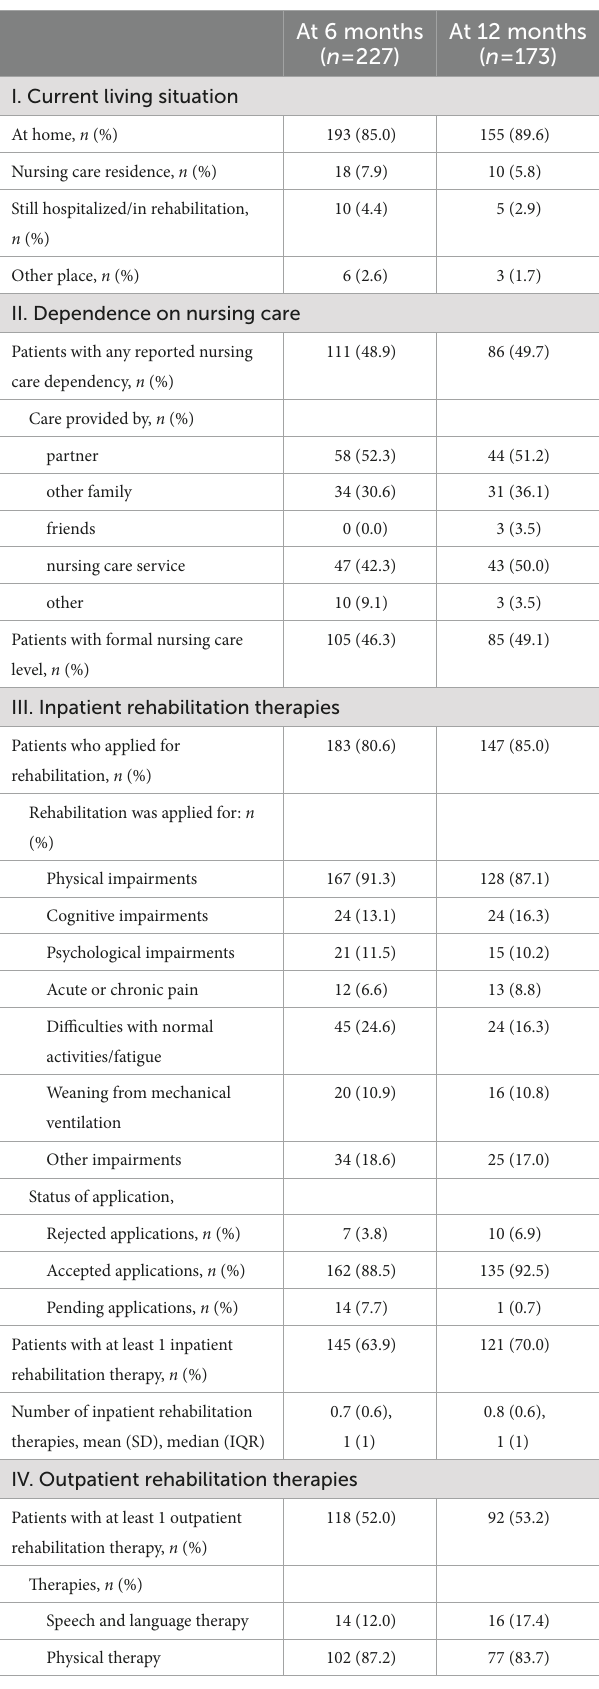
TABLE 2 Post-sepsis characteristics of